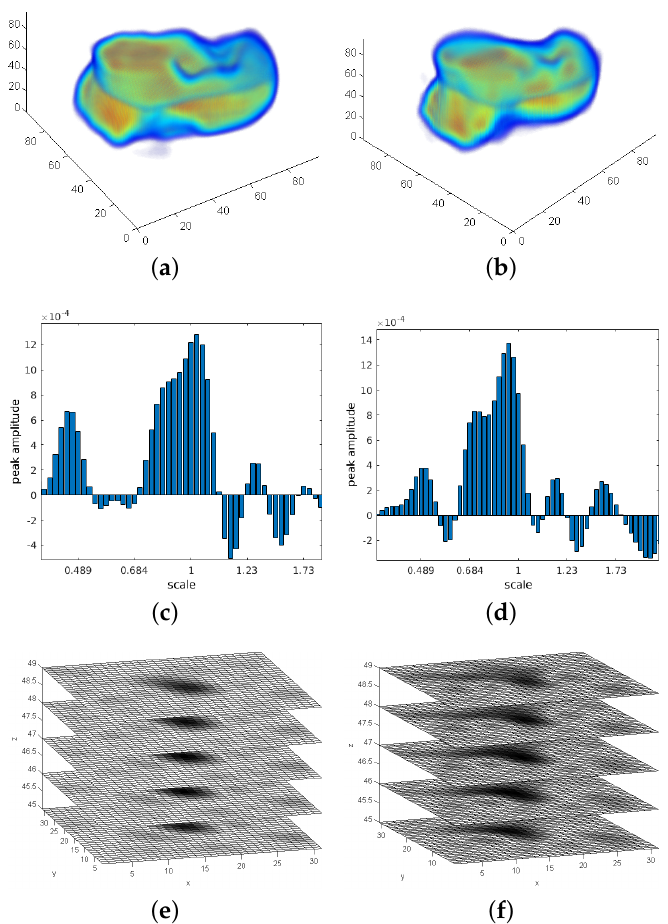
Figure 9. Example for scale registration. The top of ( a , b ) show a recognizable difference in bone sizes between two test persons. The peaks shown in ( c , d ) indicate a scale difference of 6.5% and 8% respectively. The clear 3D peak ( e ) after an alignment of both scans precisely determines the correct transformation. This is in contrast to the imprecise 3D registration peak when the scale is disregarded (scale assumed to be 1). ( a ) Top view of bone B1 of person 1. ( b ) Top view of bone B1 of person 3. ( c ) Resulting peak of the Mellin transform (scale). Registration is applied on the segmented bones. ( d ) Resulting peak of the Mellin transform (scale). Registration is applied between a segmented bone and its counterpart within the full tissue. ( e ) 3D registration peak after rotational and scale alignment of the single bones. ( f ) 3D registration peak after rotational alignment